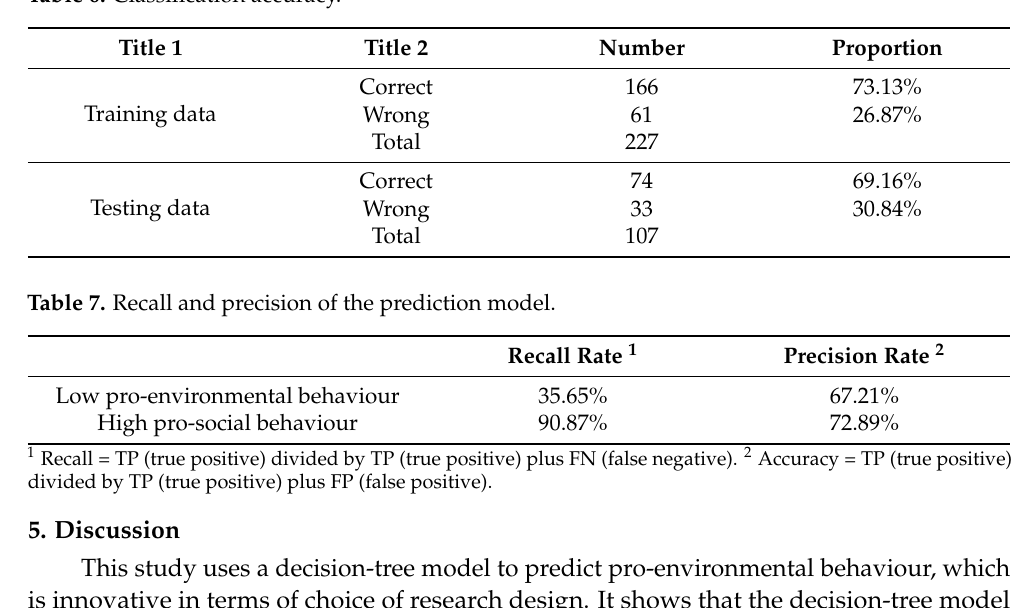
Table 6. Classification accuracy.